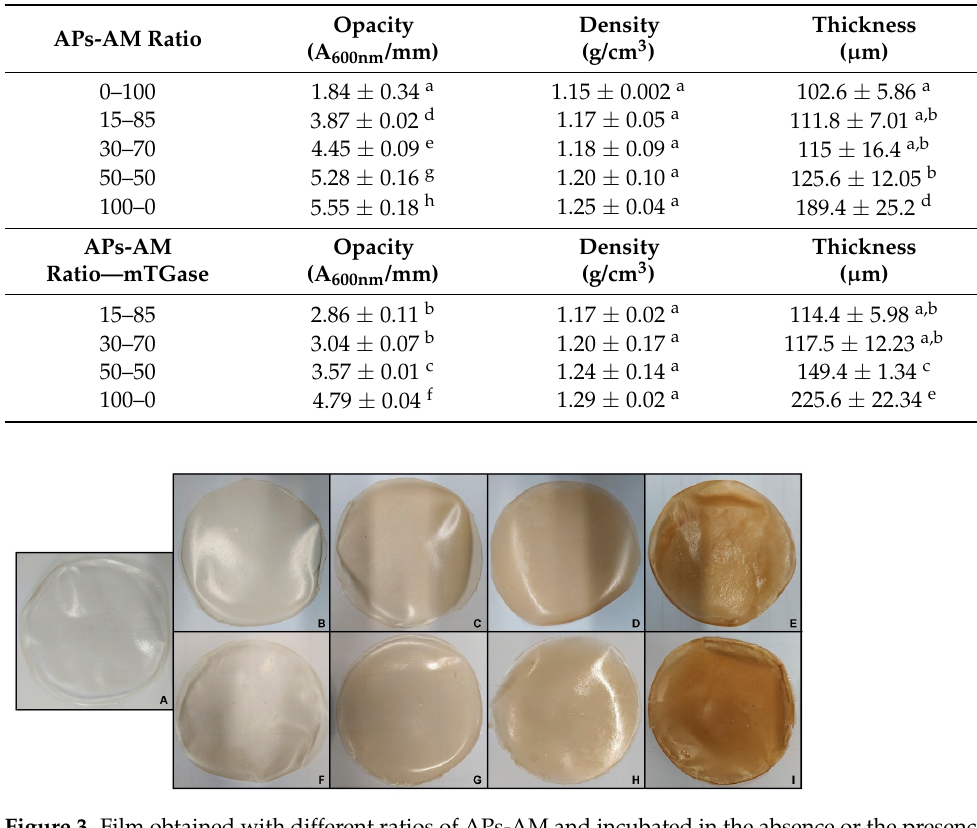
Figure 3. Film obtained with different ratios of APs-AM and incubated in the absence or the presence of mTGase: APs-AM(0–100) ( A ), APs-AM(15–85) in the absence of mTGase ( B ), APs-AM(15–85) in the presence of mTGase ( F ), APs-AM(30–70) in the absence of mTGase ( C ), APs-AM(30–70) in the presence of mTGase ( G ), APs-AM(50–50) in the absence of mTGase ( D ), APs-AM(50–50) in the presence of mTGase ( H ), APs-AM(100–0) in the absence of mTGase ( E ), APs-AM(100–0) in the presence of mTGase ( I ). Table 2. Opacity, density, and thickness of films prepared at different ratios APs-AM treated or not with mTGase (40 U/g). Different small letters (a–h) indicate significant differences among the values reported in the columns ( p < 0.05). Analyses of opacity and density were carried out in triplicate. Thickness values are reported as the average of five values.